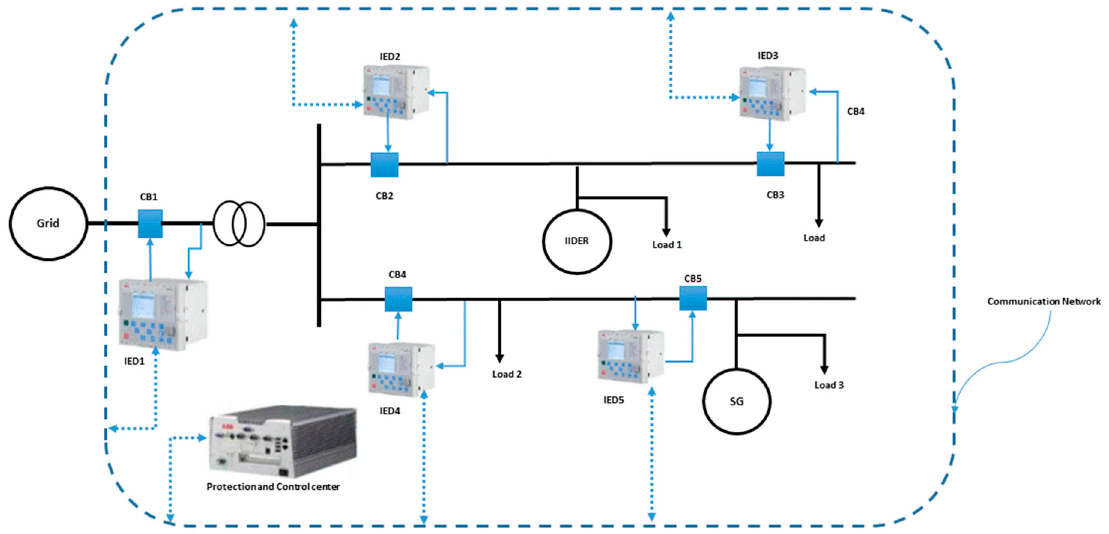
Figure 7. A typical example of an adaptive protection system.